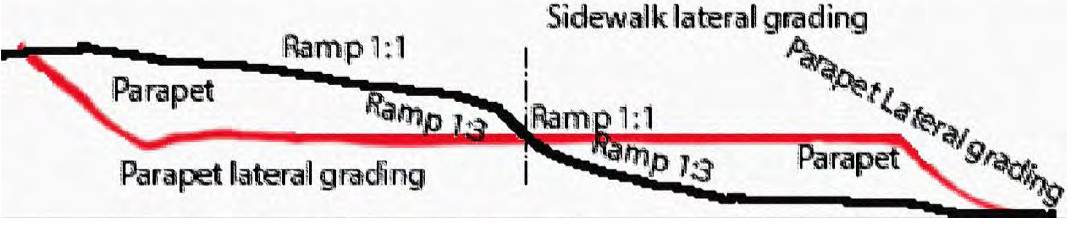
Fig. 16: Cross section in divided roads. Egyptian rule No. 159 of 1998. (The author)